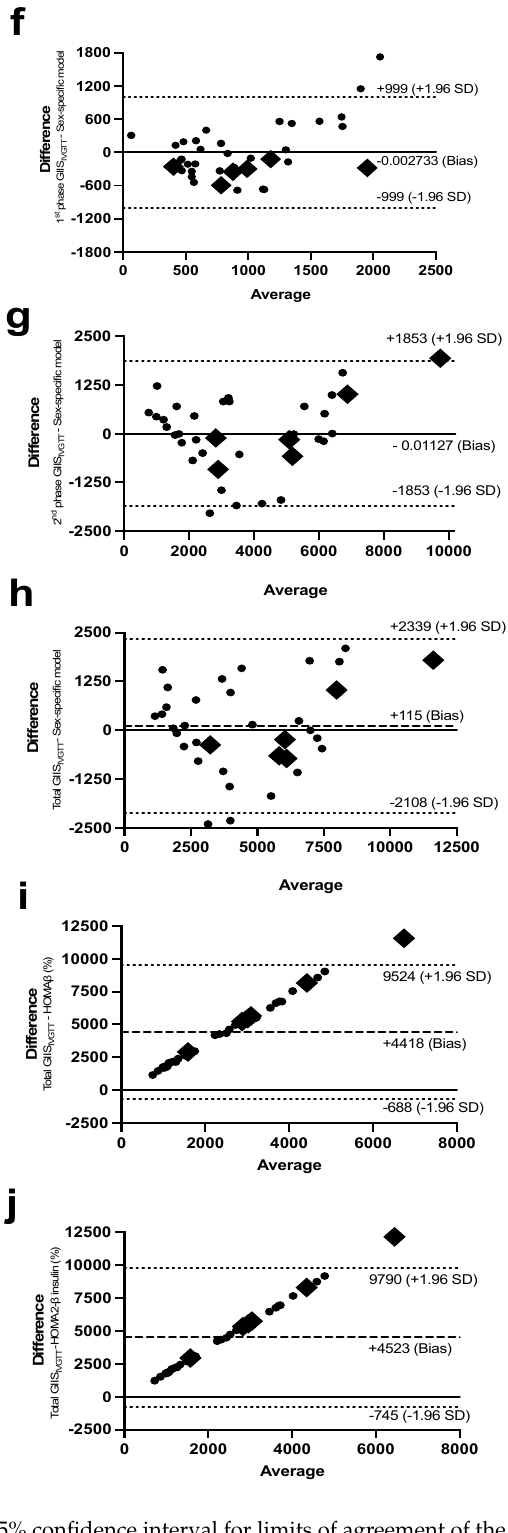
Figure 4. Bland–Altman plots with 95% confidence interval for limits of agreement of the sex-specific models, with their corresponding data for first-phase GIIS IVGTT in women ( a ) and men ( f ), second-phase GIIS IVGTT in women ( b ) and men ( g ), and total GIIS IVGTT in women ( c ) and men ( h ), and between total GIIS IVGTT , with HOMA- β insulin in women ( d ) and men ( i ), and HOMA2- β insulin in women ( e ) and men ( j ). Women are in open circles (N = 61, those with BMI > 40 kg/m 2 are in open diamonds) and men are in closed circles (N = 37, those with BMI > 40 kg/m 2 are in closed diamonds).